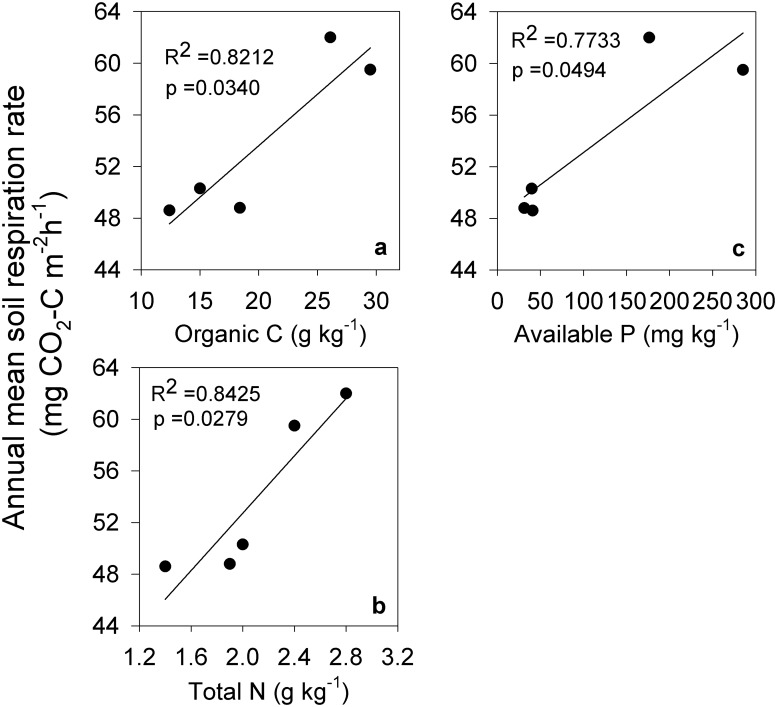
Relationship of annual mean soil respiration rate with organic C, total N, and available P content between the five experimental sites.The data points (n = 5) are the yearly average between the five different experimental sites.